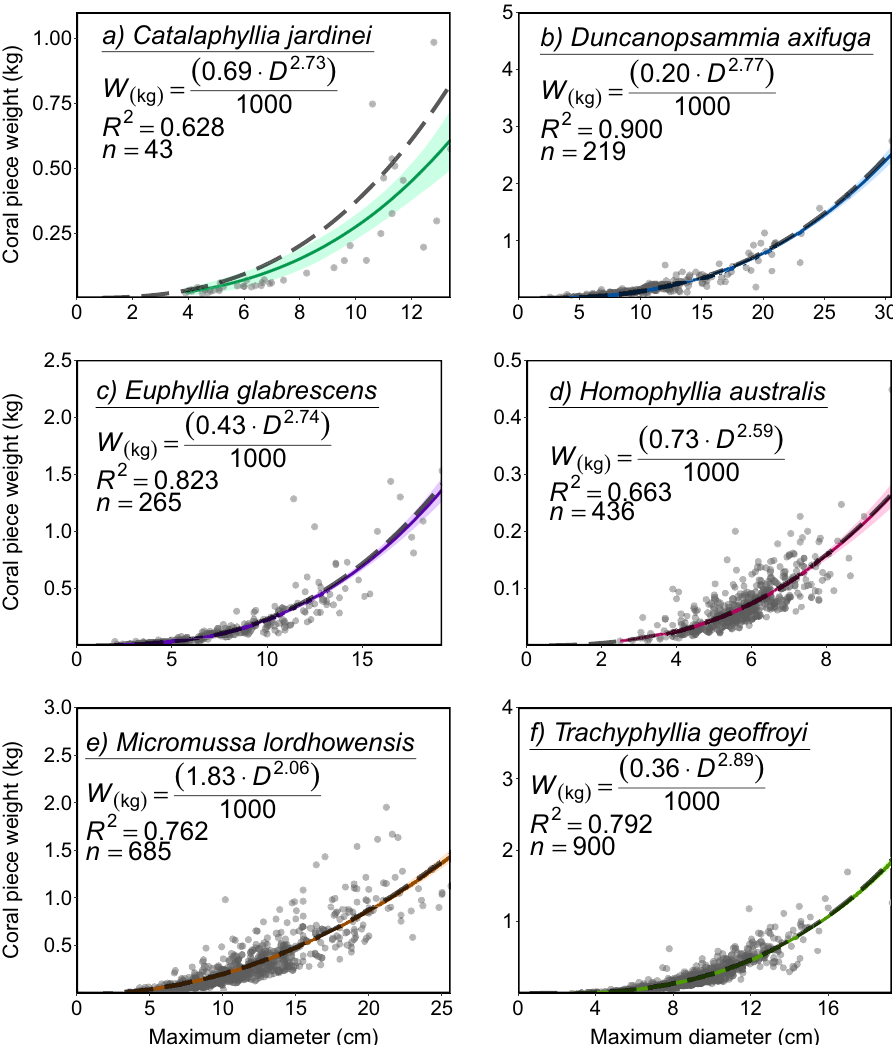
Figure 2. Modelled relationship between maximum diameter (cm) and coral weight (g) for the species: ( a ) Catalaphyllia jardinei , ( b ) Duncanopsammia axifuga , ( c ) Euphyllia glabrescens , ( d ) Homophyllia cf. australis , ( e ) Micromussa lordhowensis , ( f ) Trachyphyllia geoffroyi . Probability band of the model (0.95) is indicated by the coloured bands surrounding model line, while grey dots indicate individual datapoints, and dashed grey model line represents the displayed approximated power relationship equation. For a full list of non-linear parameter constant estimates, SE, and High Density Intervals see Online Appendix